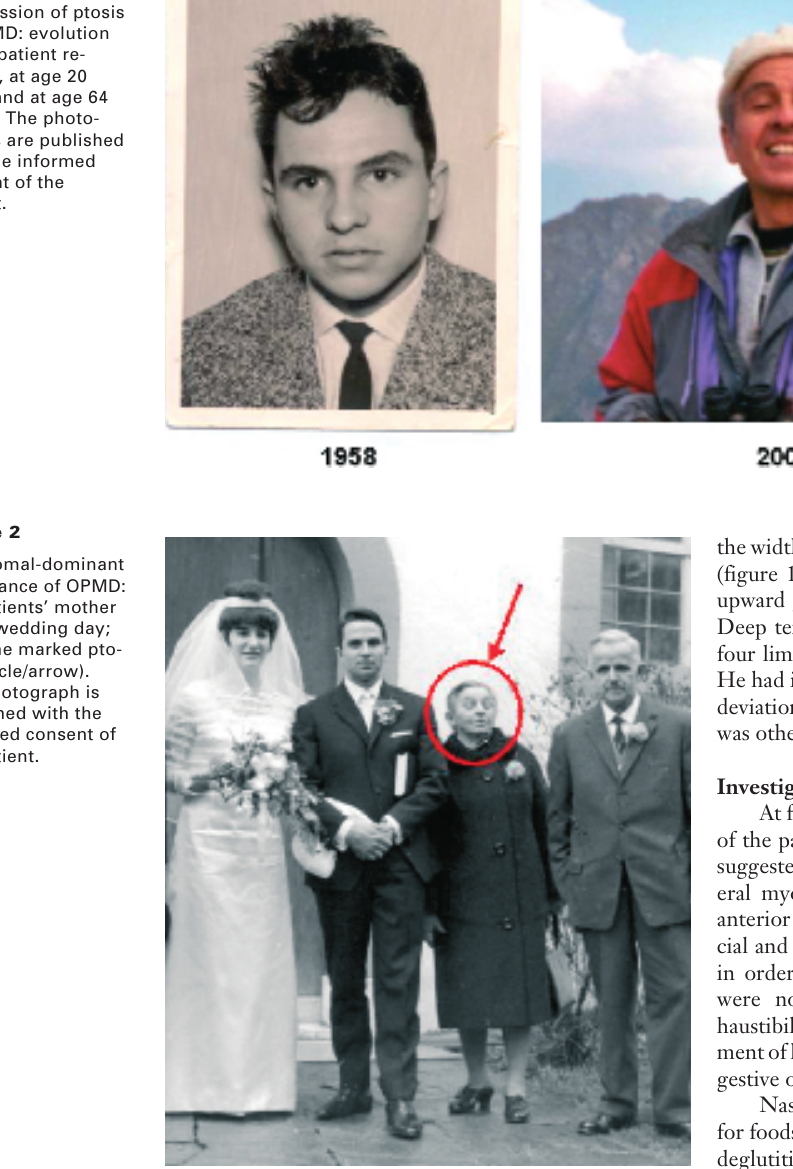
Progression of ptosis in OPMD: evolution of the patient re- ported, at age 20 (left), and at age 64 (right). The photo- graphs are published with the informed consent of the patient.